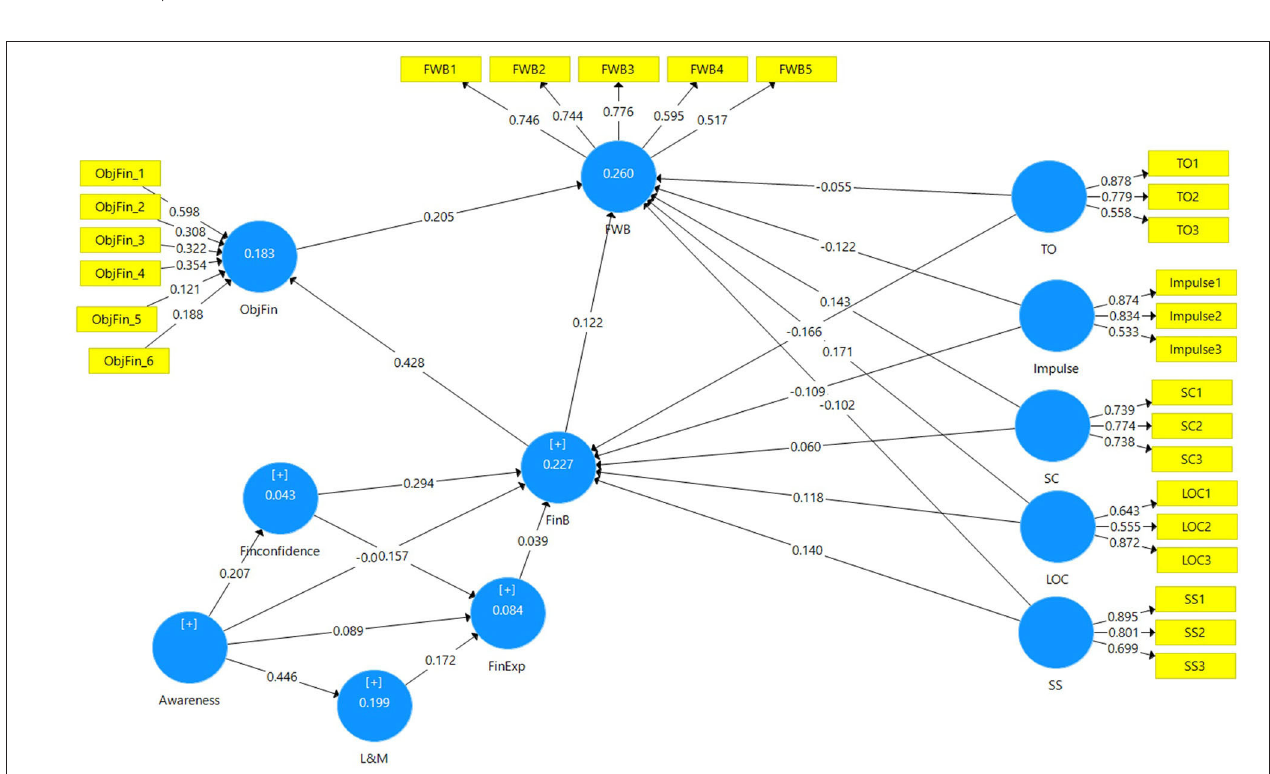
FIGURE 3 | Significance of the structural model paths. Source: SmartPLS output.